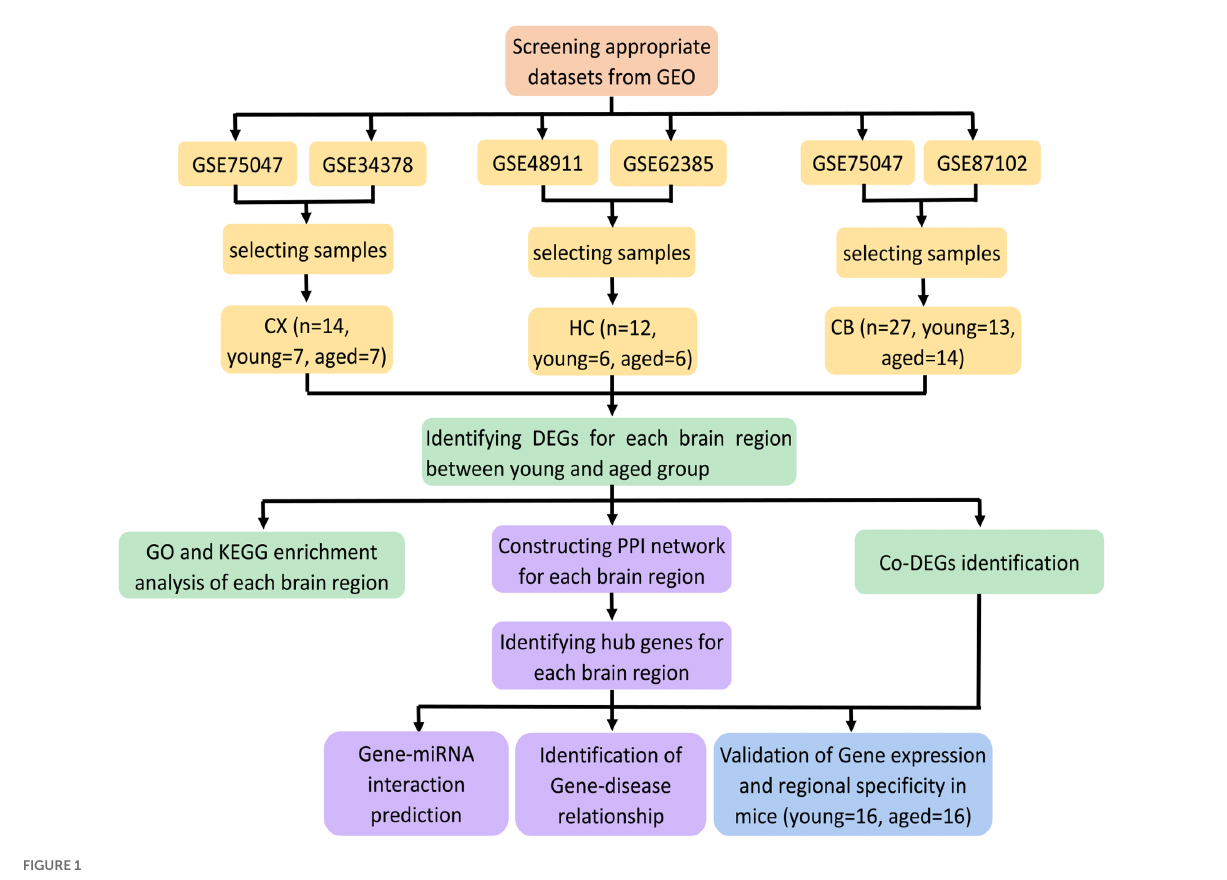
FIGURE 1 Flowchart of the